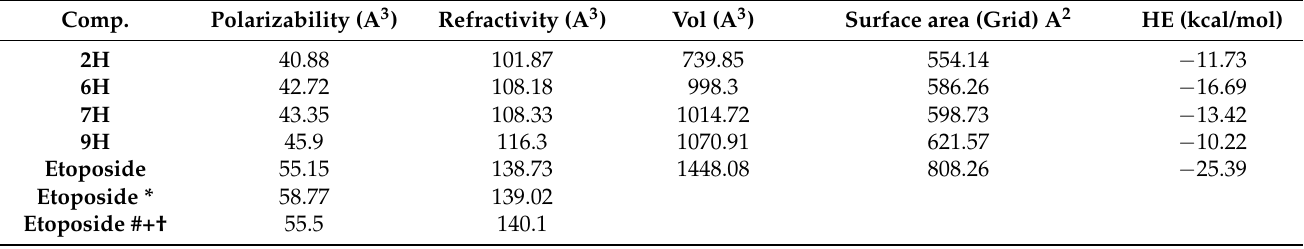
Table 7. The SAR properties of 2H , 6H , 7H , and 9H derivatives of TUDIHPP.